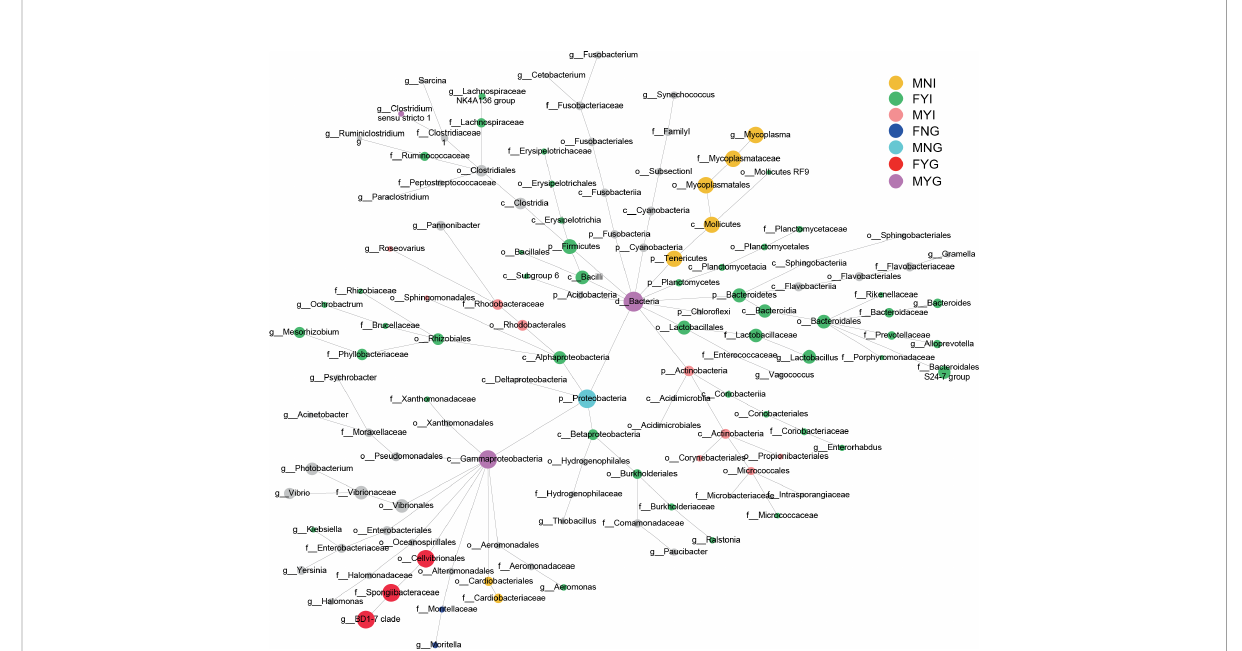
FIGURE 9 Differential network analyses of the intestine and gill bacterial communities of medium-form squid. The node indicates the species classi fi cation, and its size shows the abundance. Among them, the remaining colors show signi fi cant differences in the corresponding groups, and the black nodes represent no signi fi cant difference.